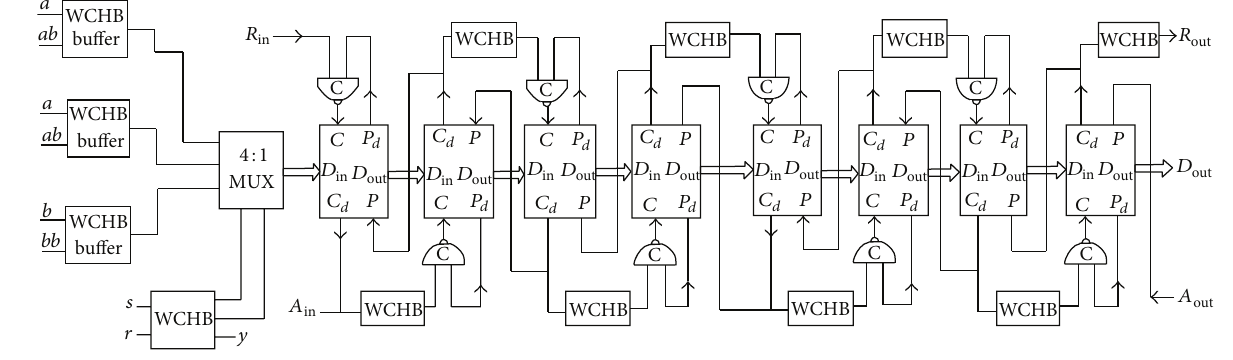
Figure 10: Block diagram of the proposed